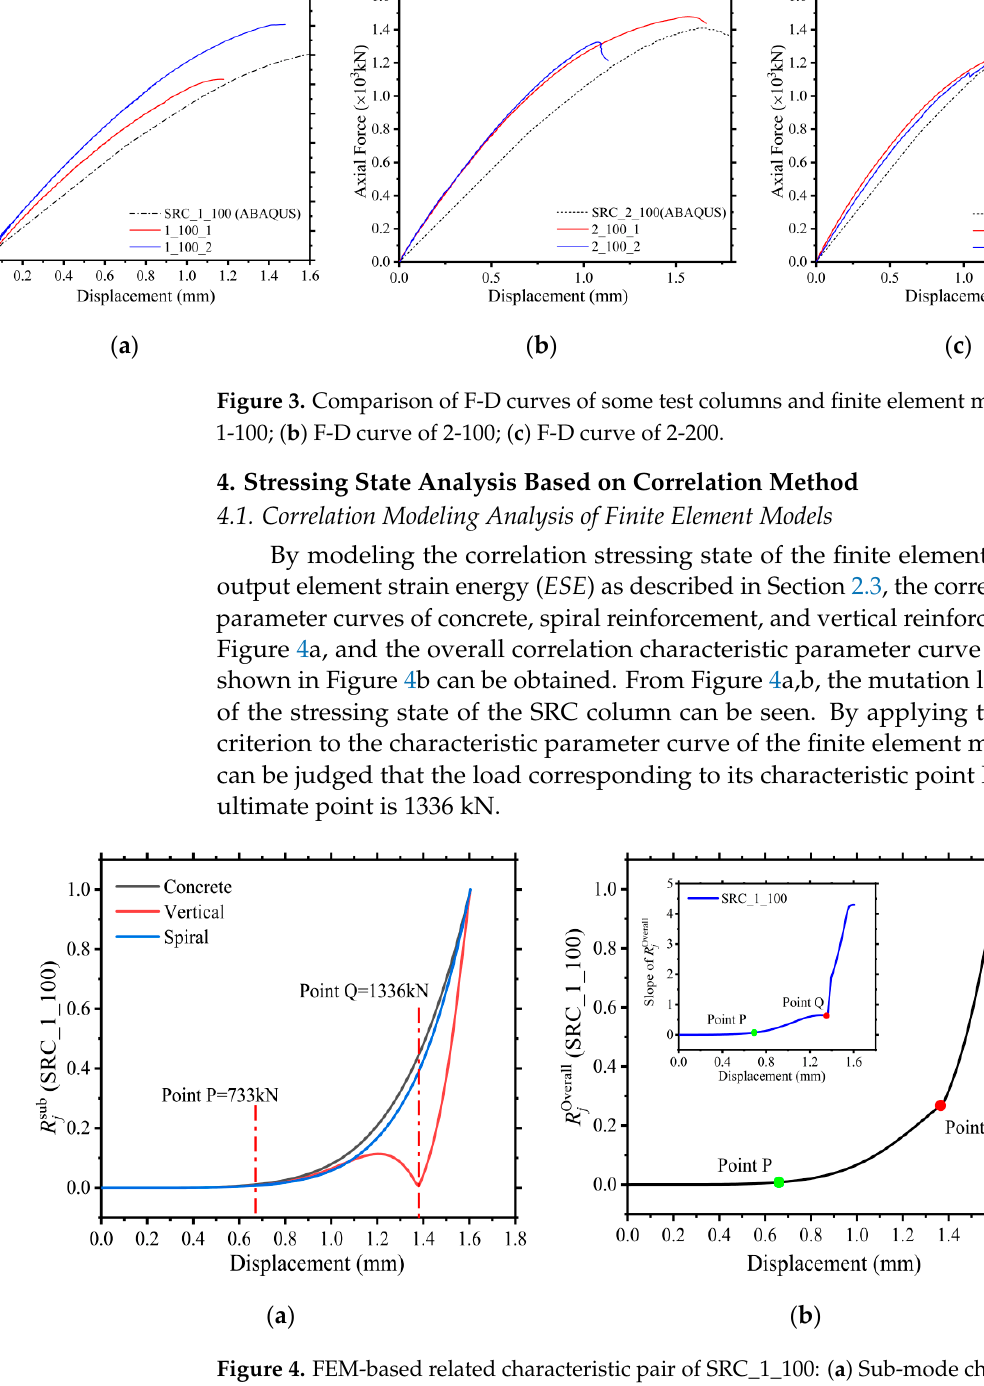
Figure 4. FEM-based related characteristic pair of SRC_1_100: ( a ) Sub-mode characteristic parame- ter curves; ( b ) Overall mode characteristic parameter curve. curves; ( b ) Overall mode characteristic parameter